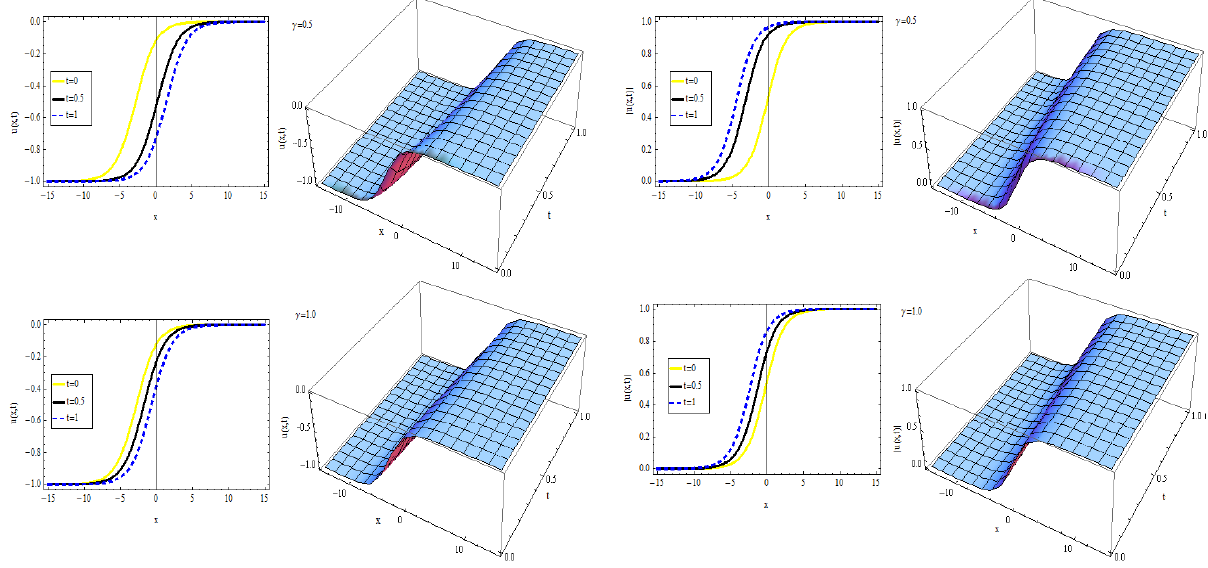
Figure 6: Graphs of (34) for conformable time-fractional Cahn-Allen equation.